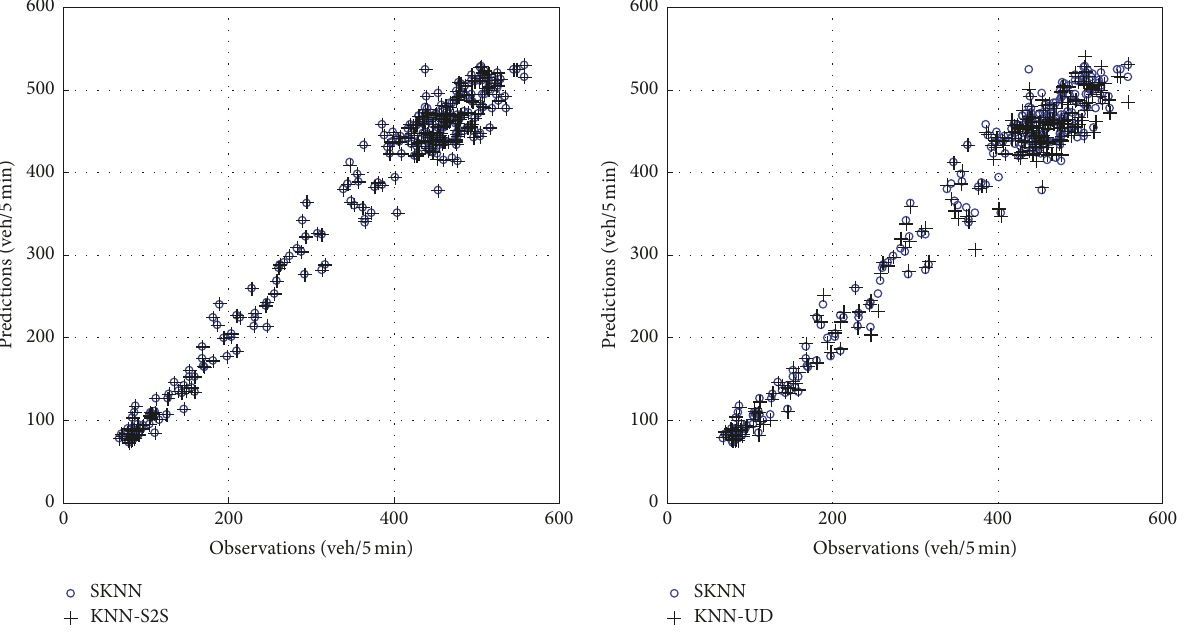
Figure 4: Conformity of predictions between two